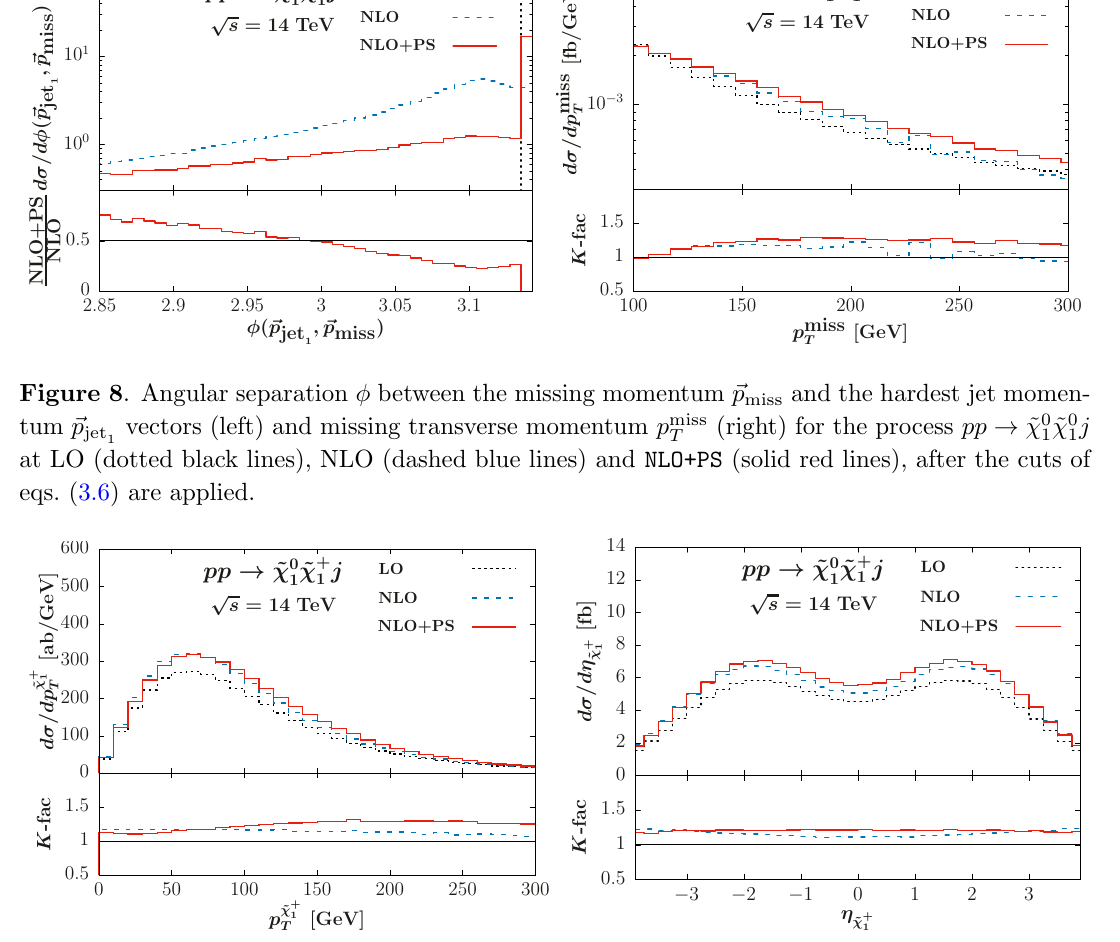
Figure 9 . Transverse-momentum (left) and pseudo-rapidity distribution (right) of the chargino in the process pp ~ (cid:31) 0 ~ (cid:31) + j at LO (dotted black lines), NLO (dashed blue lines), and NLO+PS (solid 1 1 ! red lines) within the cuts of eq. (3.5) for our default